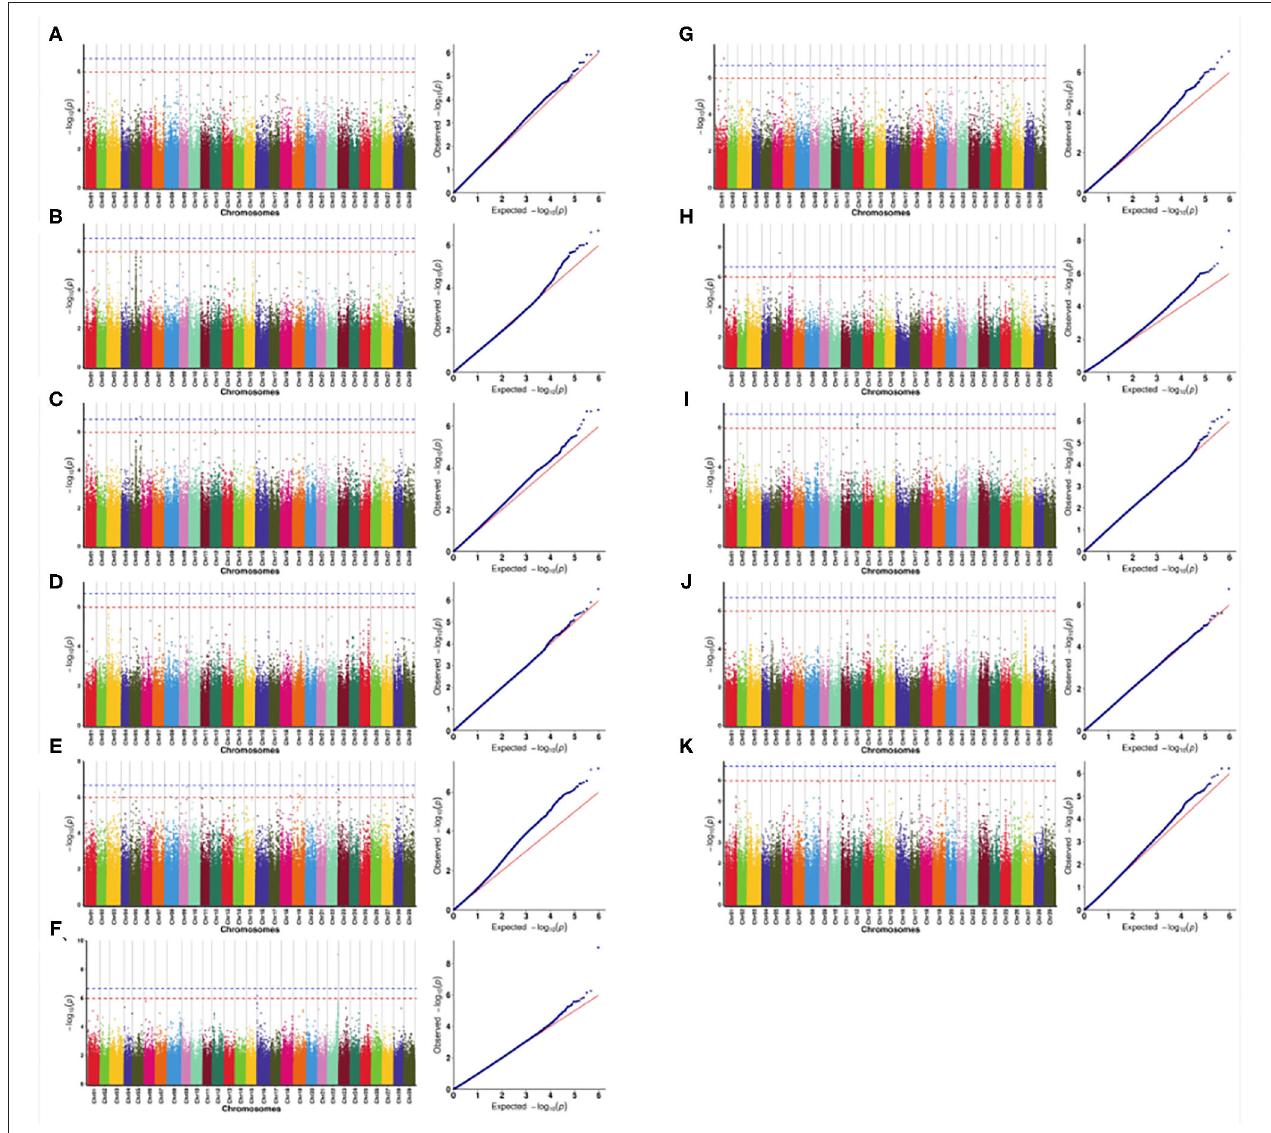
FIGURE 5 | Manhattan and QQ plots of the genome-wide association study (GWAS). (A) pollen viability; (B) the amount of pollen per flower; (C) the amount of pollen per anther; (D) the number of stamens per flower; (E) the amount of pollen per flower; (F) corolla diameter; (G) the anthocyanin content of petal; (H) the ascorbic acid content of leaf; (I) the total chlorophyll content of leaf; (J) the total phenol content of leaf; (K) the total flavonoid content of leaf. The blue dotted line represents a level of 0.01, and the red dotted line represents a level of